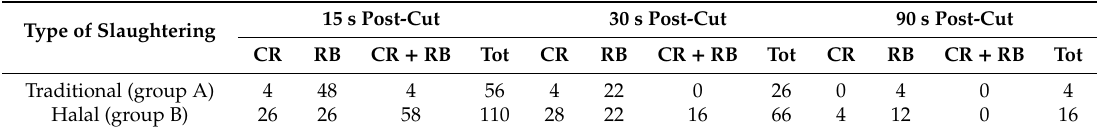
Table 1. Presence of corneal reflex (CR) and rhythmic breathing (RB) or both (CR + RB) in lambs at